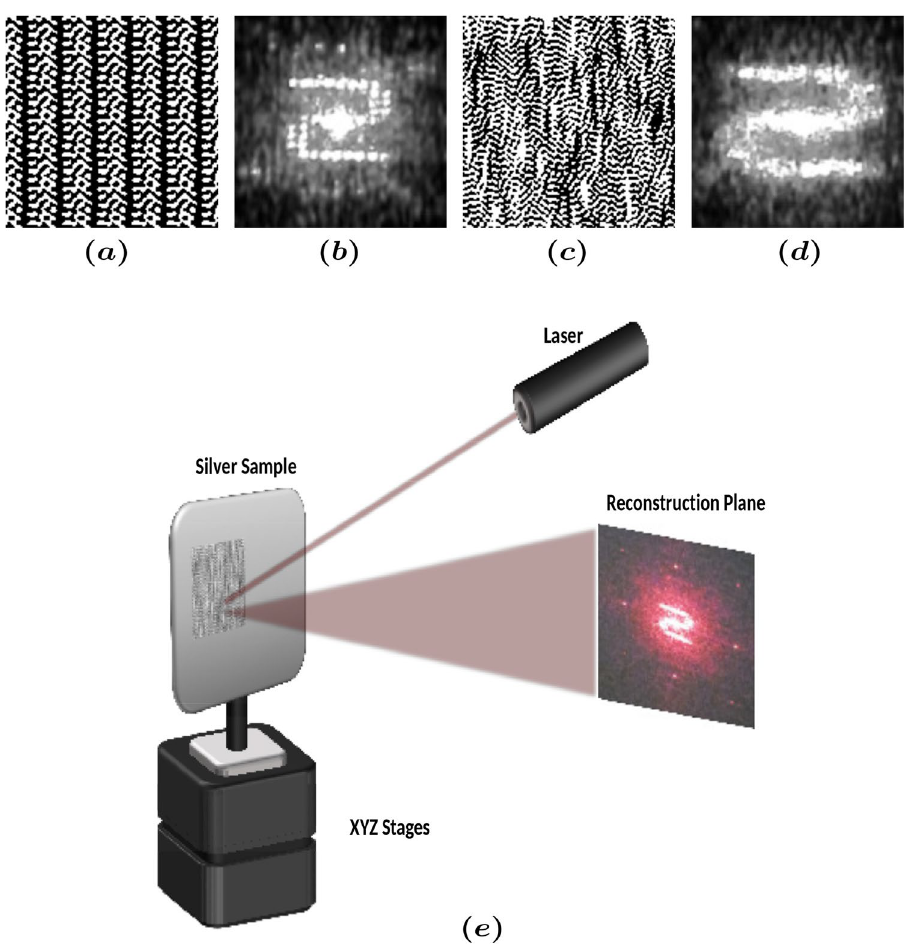
Figure 1. Holographic masks ( a , c ) and reconstructed images ( b , d ) for beam Splitter ( a ) and beam Diffuser ( c ) structure design of a CGH and the reconstruction setup ( e